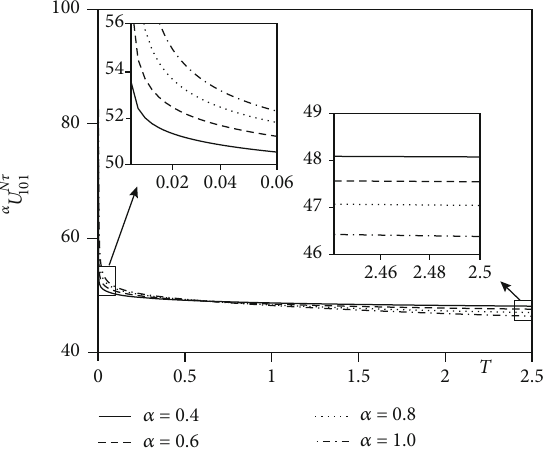
Figure 5: Numerical solution at x = 100 for maturity 0 ≤ T ≤ 2 : 5 with α = 0 : 4,0 : 6,0 : 8 , and